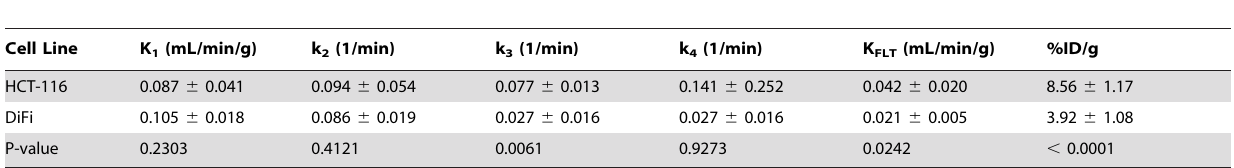
Table 1. Kinetic parameters derived from compartmental modeling of dynamic [ 18 F]-FLT PET scans in HCT-116 and DiFi tumor xenografts.